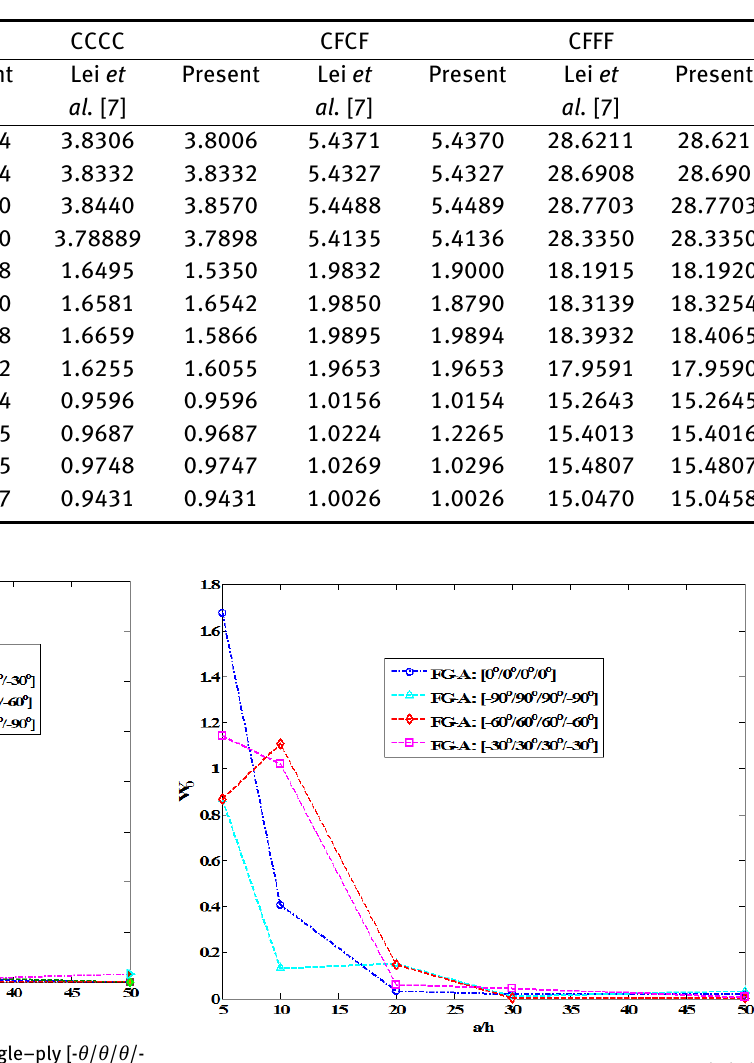
Figure 7: The non-dimensional deflection W o for angle–ply [- θ / θ / θ /- θ ] FG-A plate with different lamination